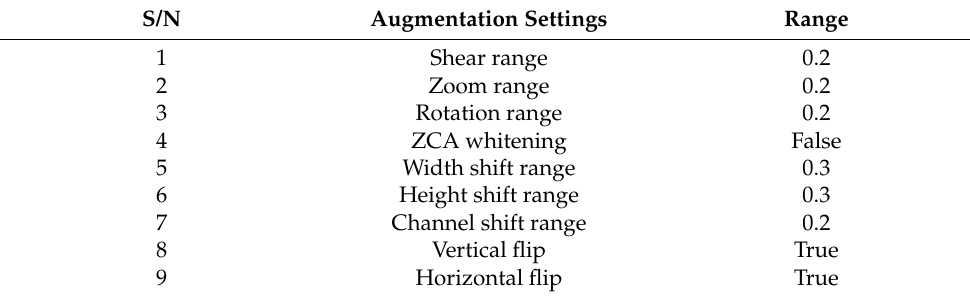
Table 2. Image Augmentation